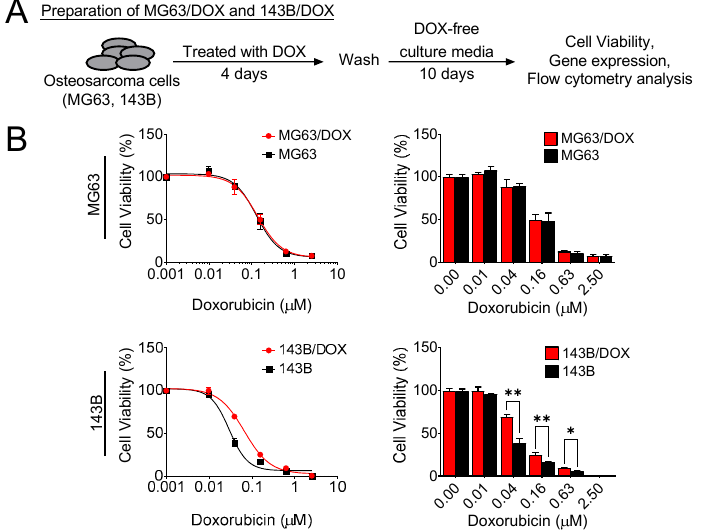
Figure 1. Doxorubicin enhances chemoresistance in osteosarcoma cells. ( A ) Schematic of MG63/DOX and 143B/DOX cell preparation. ( B ) MG63/DOX and 143B/DOX cell viability after treatment with doxorubicin. Cells were treated with various concentrations of doxorubicin for 4 days, and then the MTS assay was performed to analyze cell viability. The data represent the means ± SD. * p < 0.05 and ** p < 0.01 vs. their parental cells.